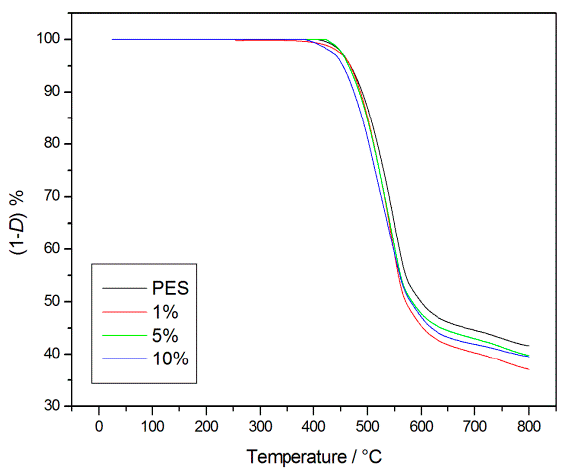
Figure 16. Thermogravimetric Analysis (TGA) of the coPES electrospun veils.